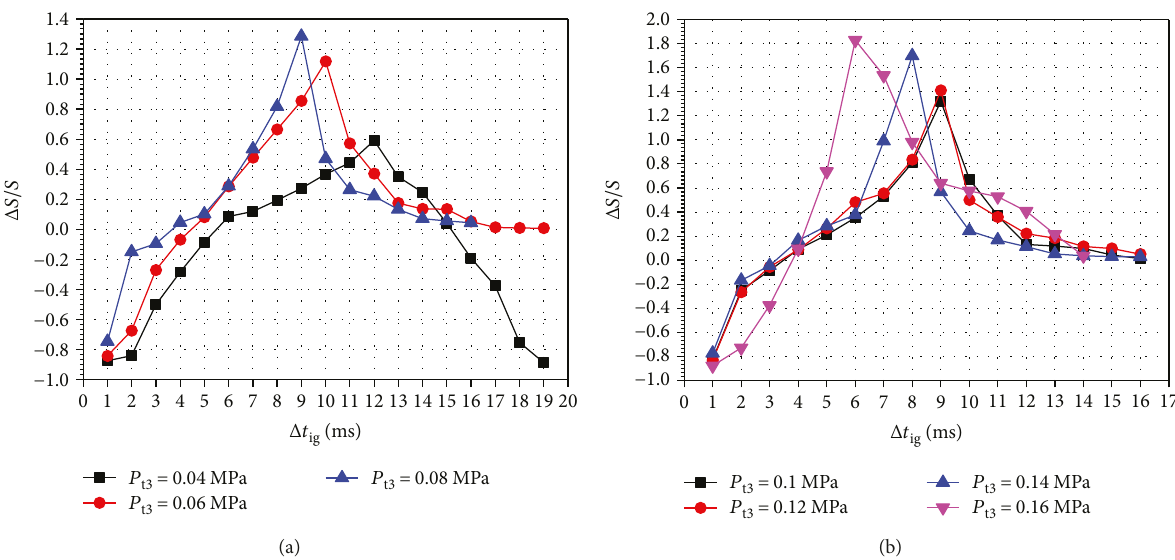
Figure 4: E ff ect of inlet pressure on the growth rate of the fl ame area. (a) P